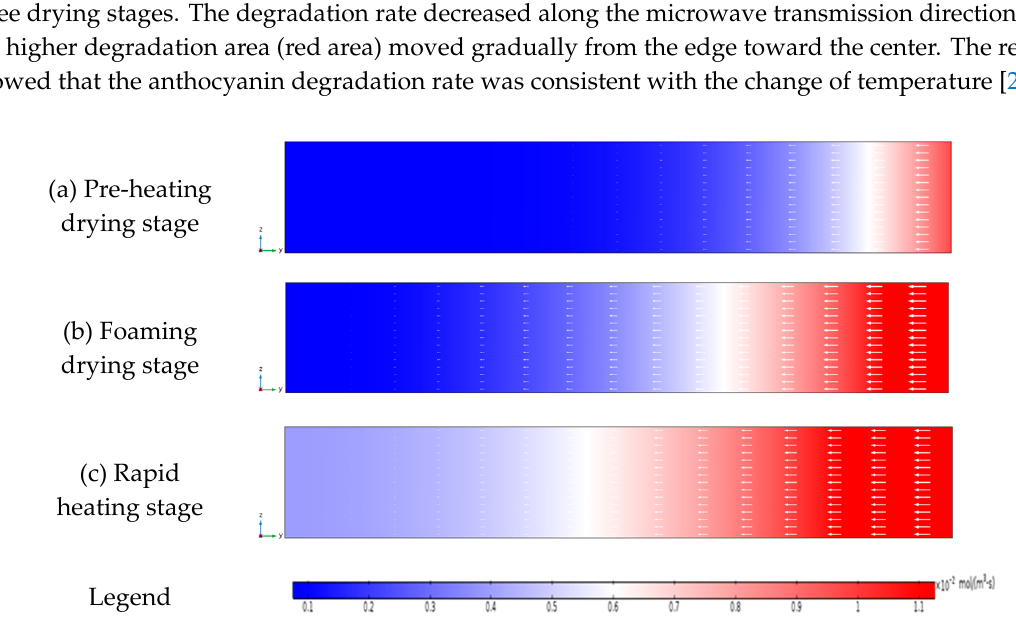
Figure 15. The distribution of the anthocyanin degradation rates during di ff erent drying